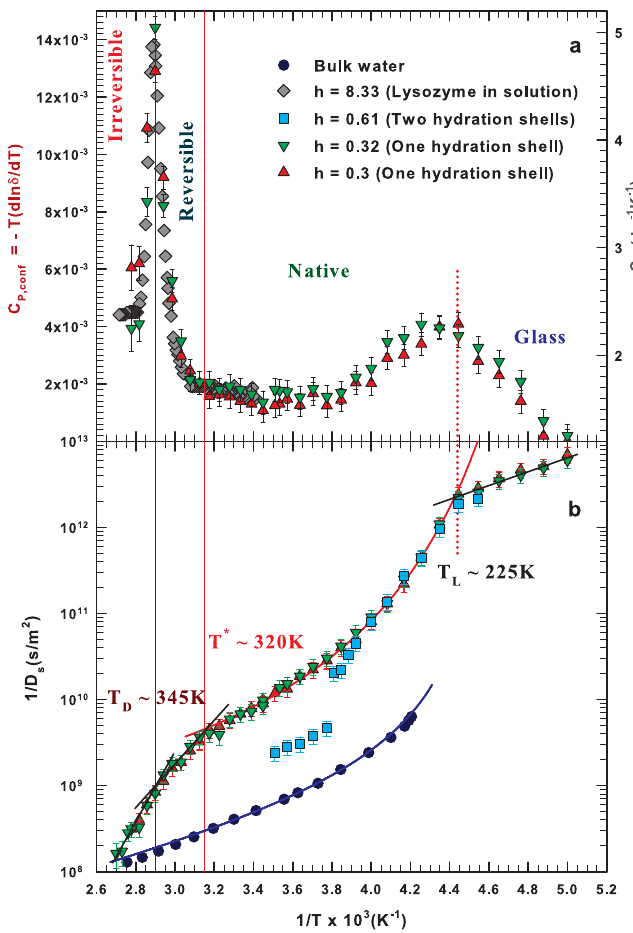
Figure 3. ( a ) The isobaric specific heat measured by means of temperature modulated scanning calorimetry for lysozyme in solution with h = 8.33 (grey diamonds; right axis) [10], and the configurational specific heat evaluated with static Nuclear Magnetic Resonance (NMR) by means of the water proton chemical shift for lysozyme with a single hydration shell, h = 0.32 and 0.3 (green triangles down and red triangles up, respectively; left axis) [59,61]. ( b ) The reciprocal of the self-diffusion coefficient for bulk water (blue circles) and lysozyme hydration water with h = 0.61 (cyan squares), 0.32 (green triangles down) and 0.3 (red triangles up) measured by means of the pulsed field gradient NMR technique [60]. The panels share the same x -axis, i.e., the inverse temperature. Figure adapted from Reference